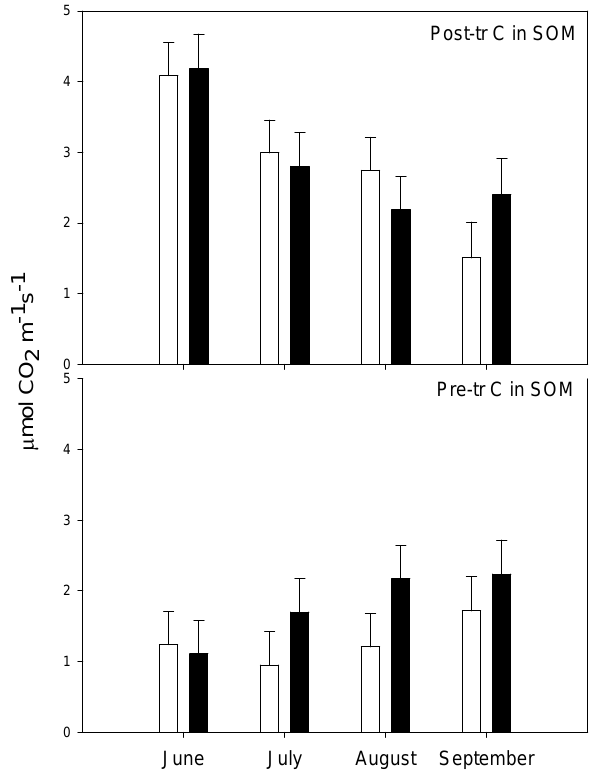
Fig. 4. The contribution of post- and pre-treatment soil organic car- bon to daytime and nighttime soil respiration at FACTS-1 during the growing season of 2004. Values are means ( n = 3) ± standard